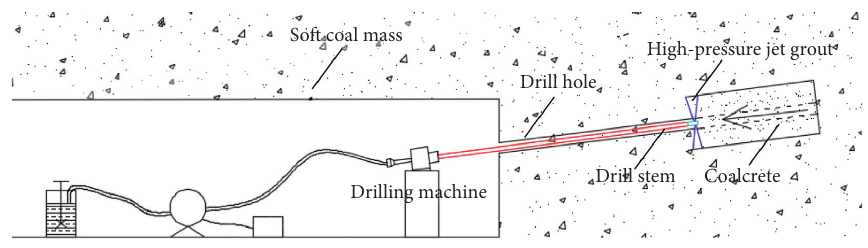
Figure 2: Schematic diagram of JG treatment. Table 1: Design of shear